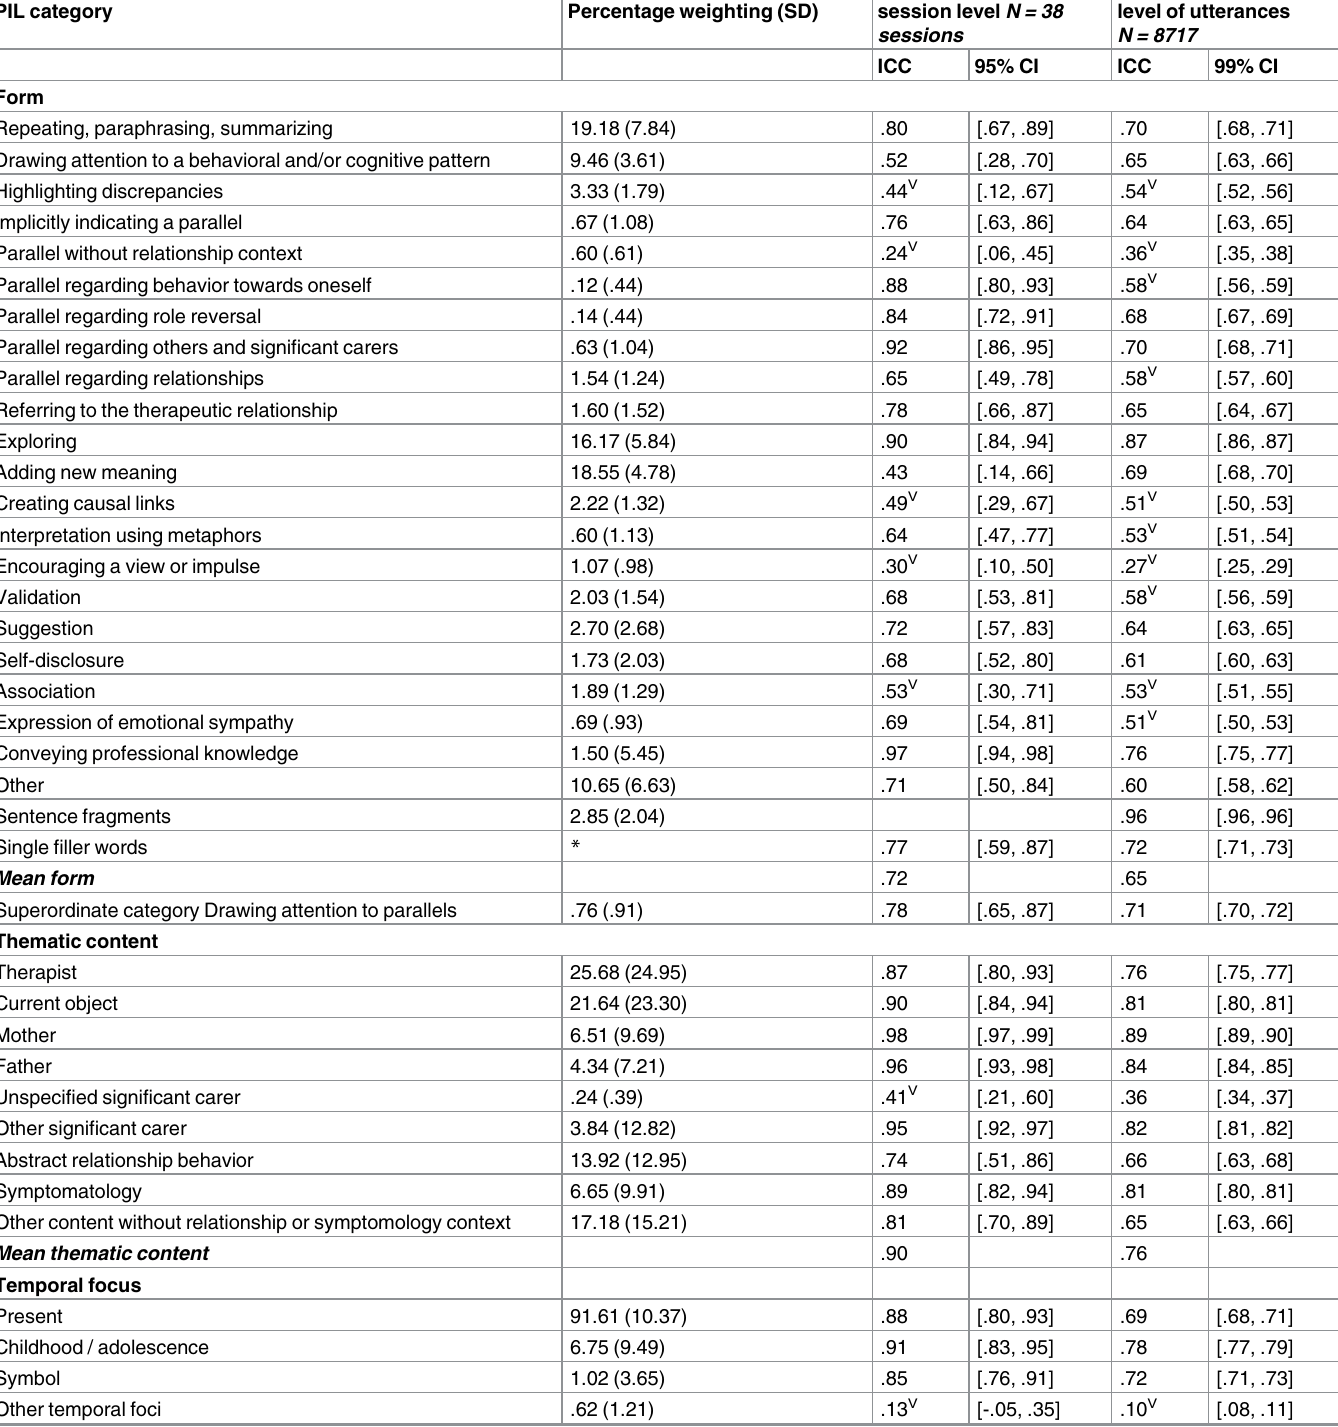
Table 2. Intraclass correlations (ICC) for each PIL category in the three characteristic dimensions: form, thematic content, temporal focus. PIL